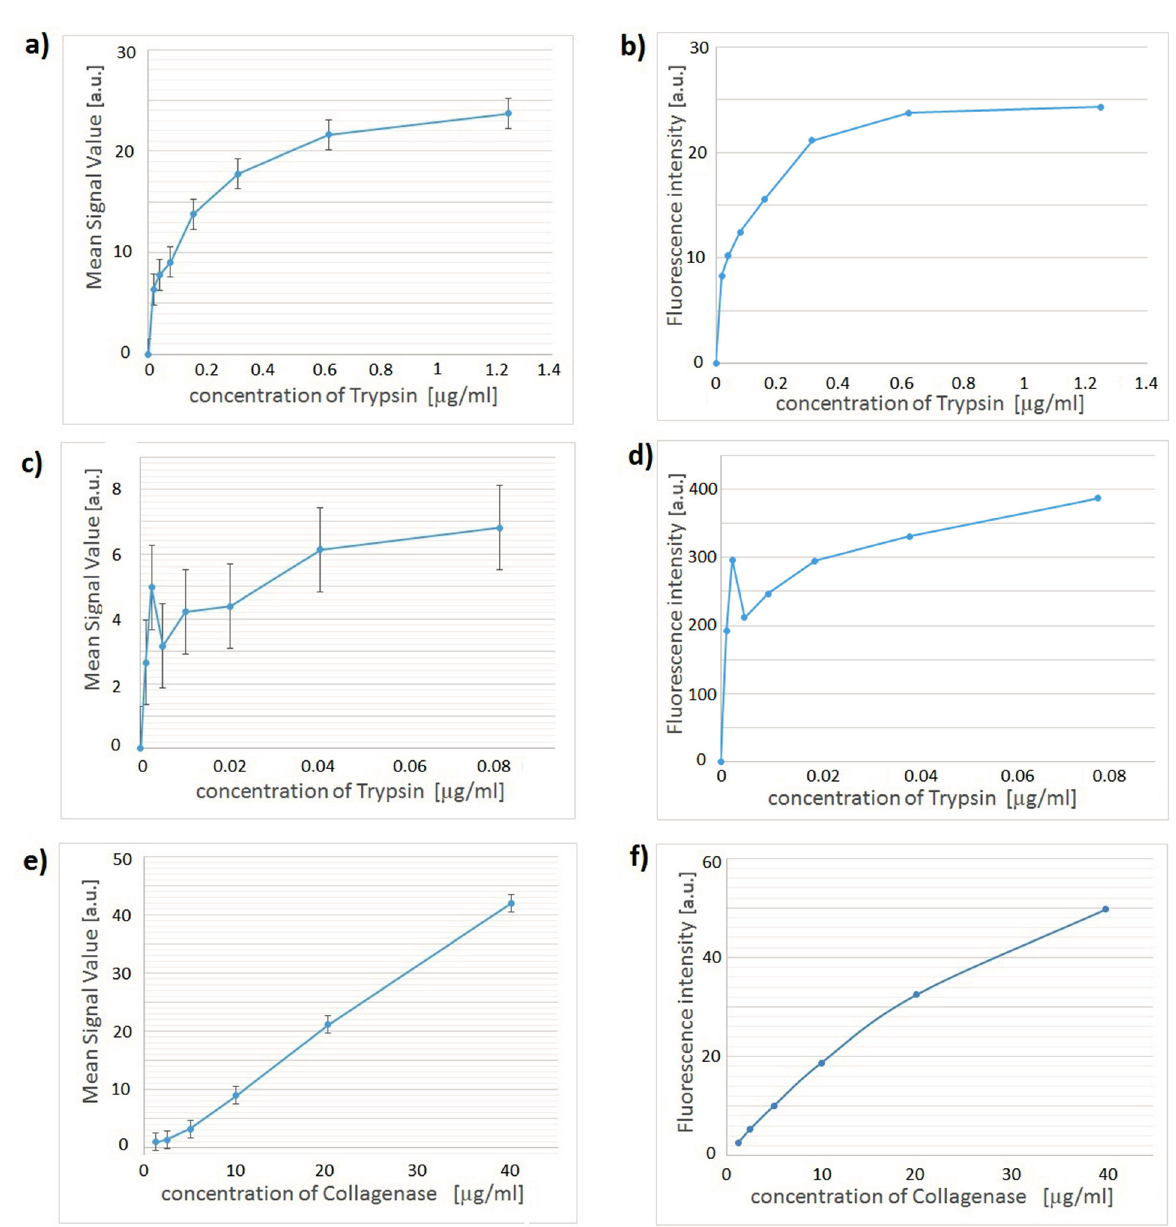
Figure 4. Assay signal as a function of analyte concentration for trypsin and collagenase assays. ( a ) Trypsin assay with smartphone device; ( b ) Trypsin assay with Cary Eclipse readout with photomultiplier detector voltage option set to ‘Low’. Uncertainty of each data point is 0.1; ( c ) Trypsin assay with smartphone device at low concentrations; ( d ) Trypsin assay at low concentrations with Cary Eclipse readout with photomultiplier detector voltage option set to ‘Medium’. Uncertainty of each data point is 2.7; ( e ) Collagenase assay with smartphone device; ( f ) Collagenase assay with Cary Eclipse readout with photomultiplier detector voltage option set to ‘Low’. Uncertainty of each data point is